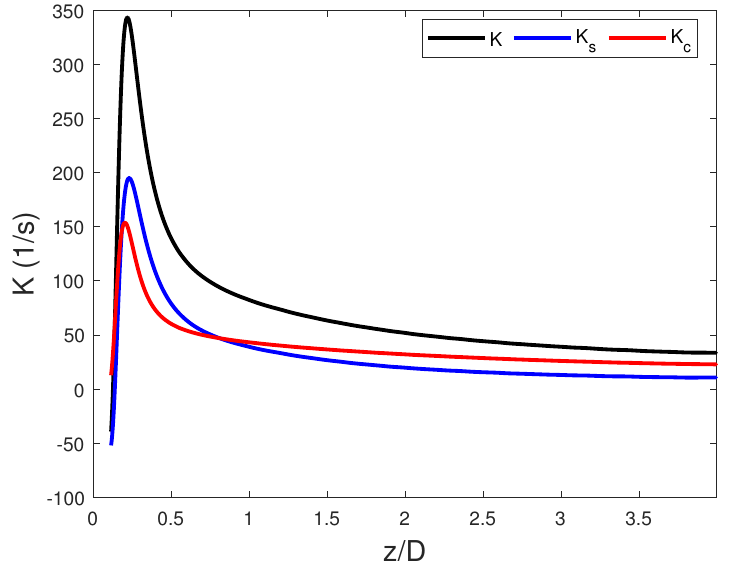
Figure 5. Stretch rate K along with contributions from flow strain K s and flame curvature K c as a function of axial length scaled with bluff body diameter for φ = 0.2